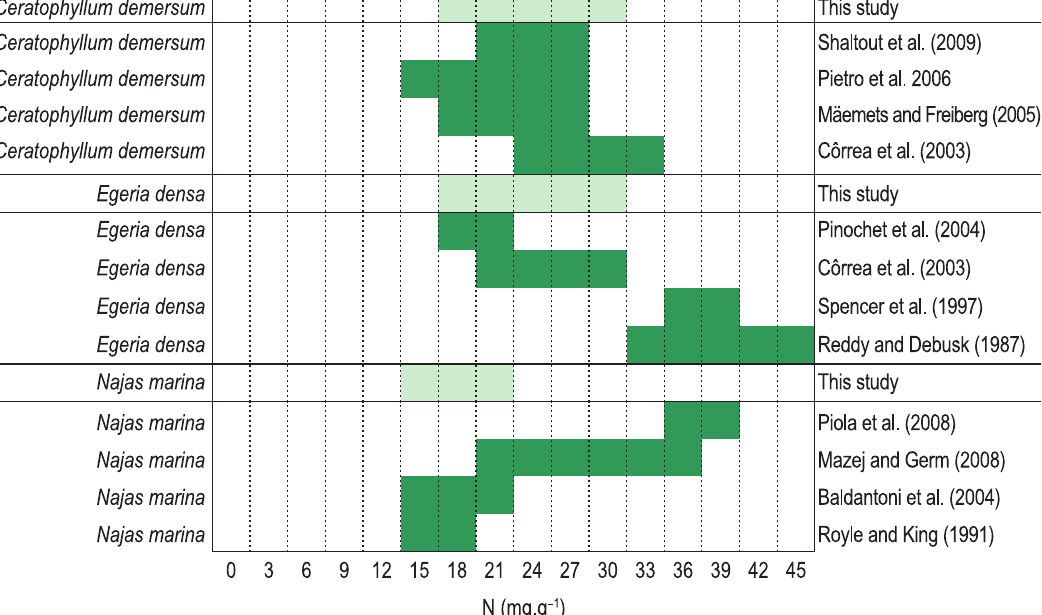
Figure 7. Nitrogen content in macrophytes, expressed as milligram per gram of dry matter (mg.g -1 ), using data from this study and from